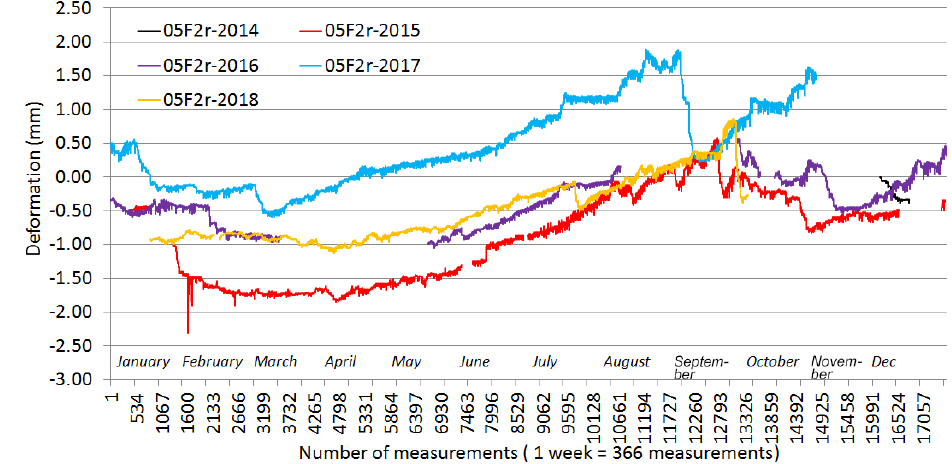
Figure 13. Annual time series plots of the 05F2 crackmeter showing partly repetitive seasonal deformation